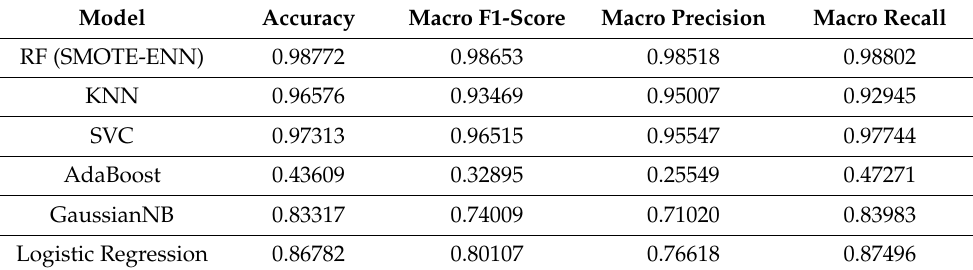
Table 15. Classification Performance Comparison of Model with Existing ML Models.